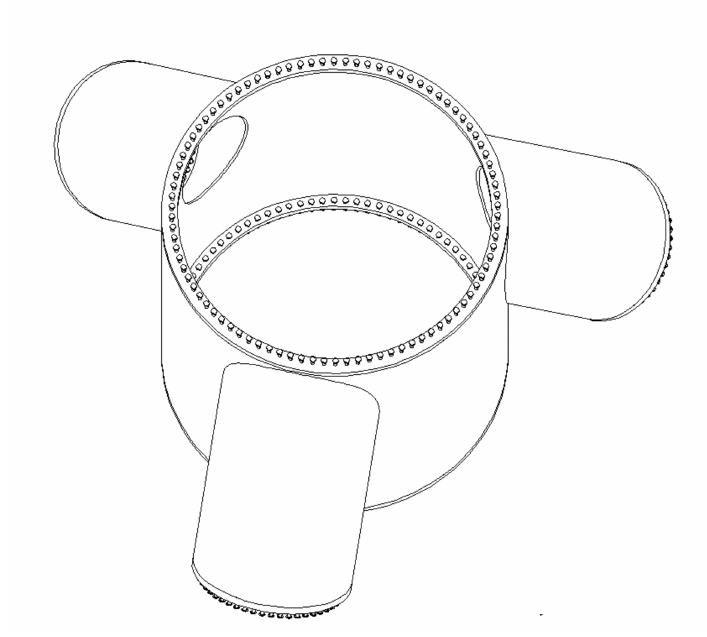
Figure 4. Details of a unified upper junction